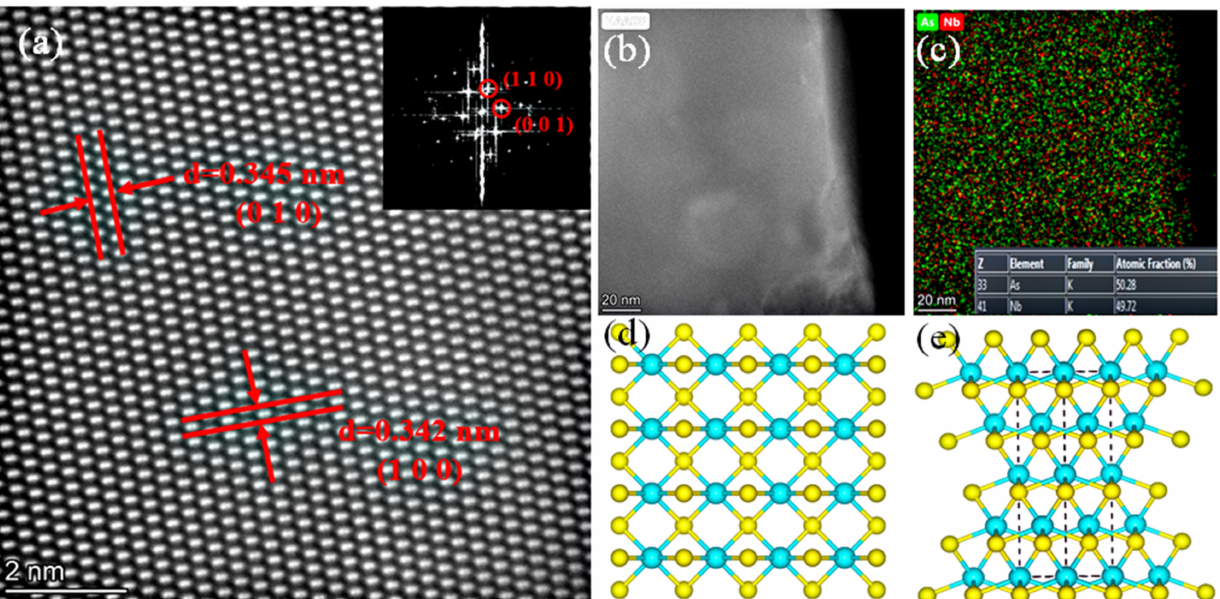
Figure 4. ( a ) HAASF-STEM images of NbAs single crystal (the illustration is FFT pattern). ( b ) TEM images of bulk NbAs placed on an ultra-thin carbon film. ( c ) EDX mapping of bulk NbAs. ( d ) and ( e ) show the (001) and (110) facets of NbAs single